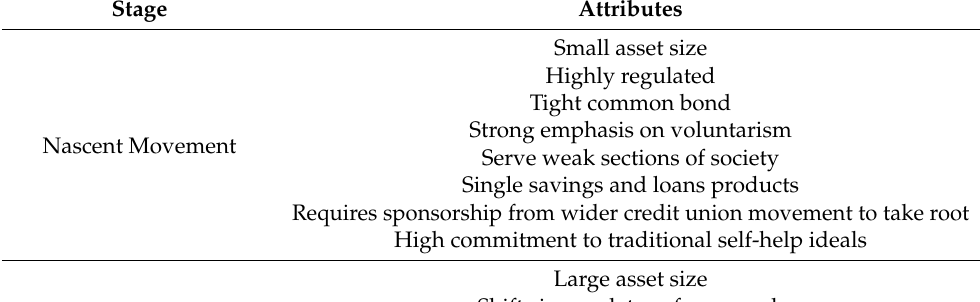
Table 1. Stages of credit union